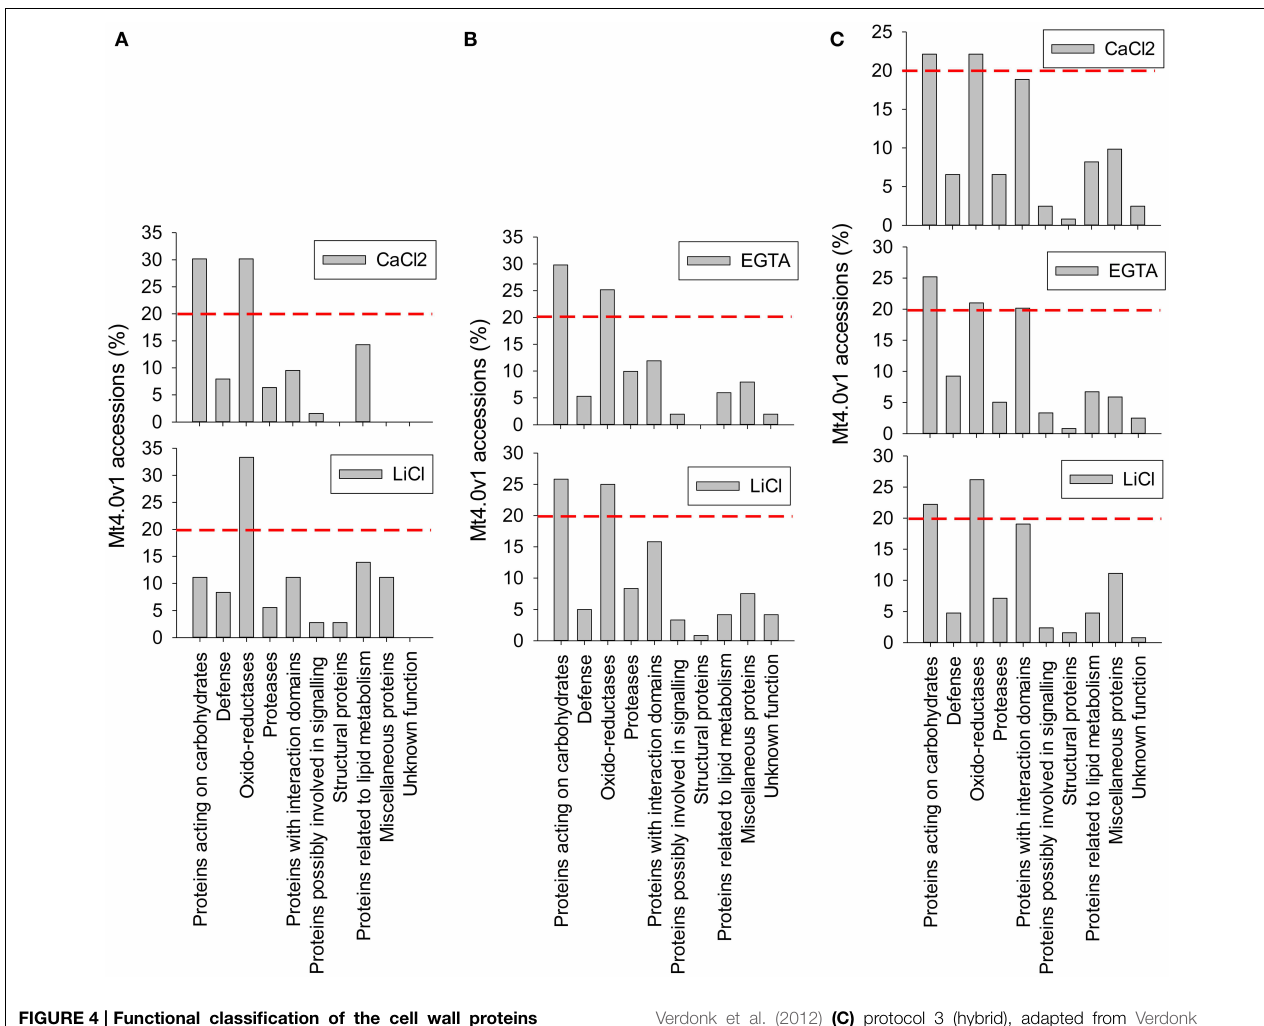
FIGURE 4 | Functional classification of the cell wall proteins (CWPs) identified by LC-MS/MS analysis of the different fractions. Calculations were made relatively to the number of non-redundant Mt4.0v1 accessions identified in each fraction. A red line was arbitrary drown at the level 20% to allow a rapid comparison of the most represented classes of proteins in each fraction. (A) protocol 1, adapted from Watson et al. (2004) (B) protocol 2, adapted from